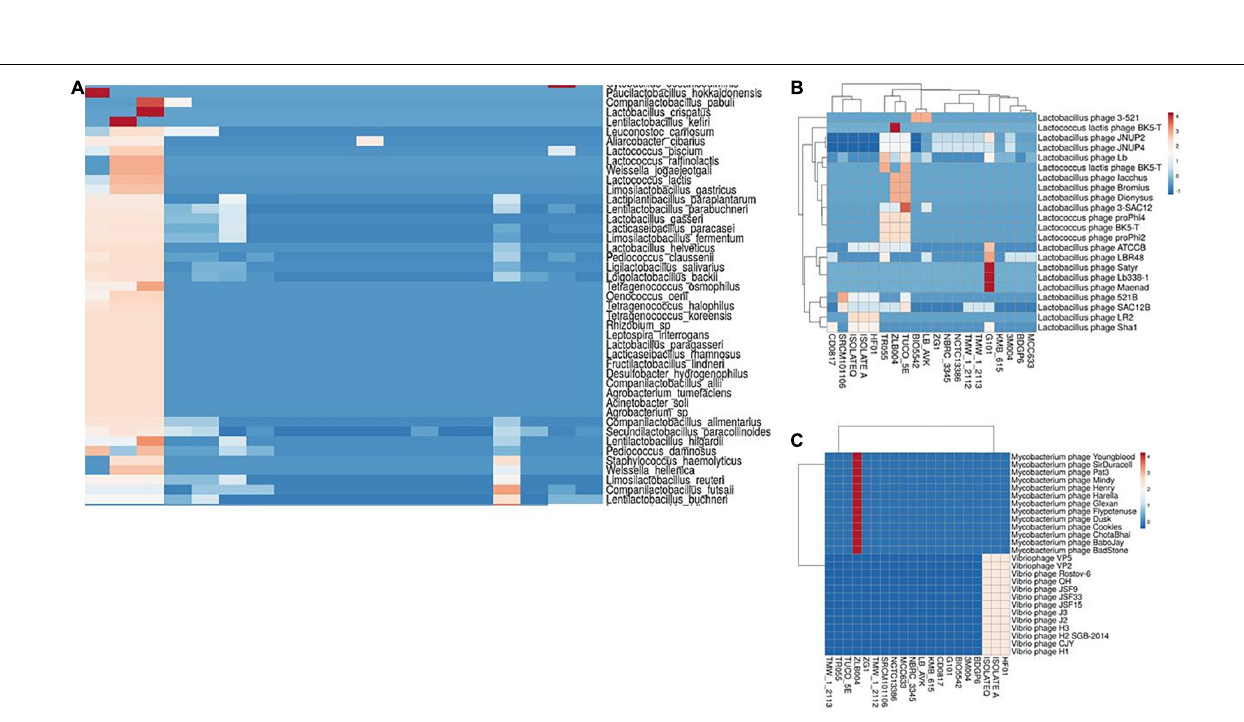
FIGURE 7 | Cluster analysis of homology of spacer in L. brevis strains targeting with different classes of bacterial plasmids (A) , Lactobacillus phages (B) , and Mycobacterium and Vibrio phages (C) . Each box showing the presence of target phages and the color range indicates the frequency of corresponding targets. Blue to red indicates the low number to high